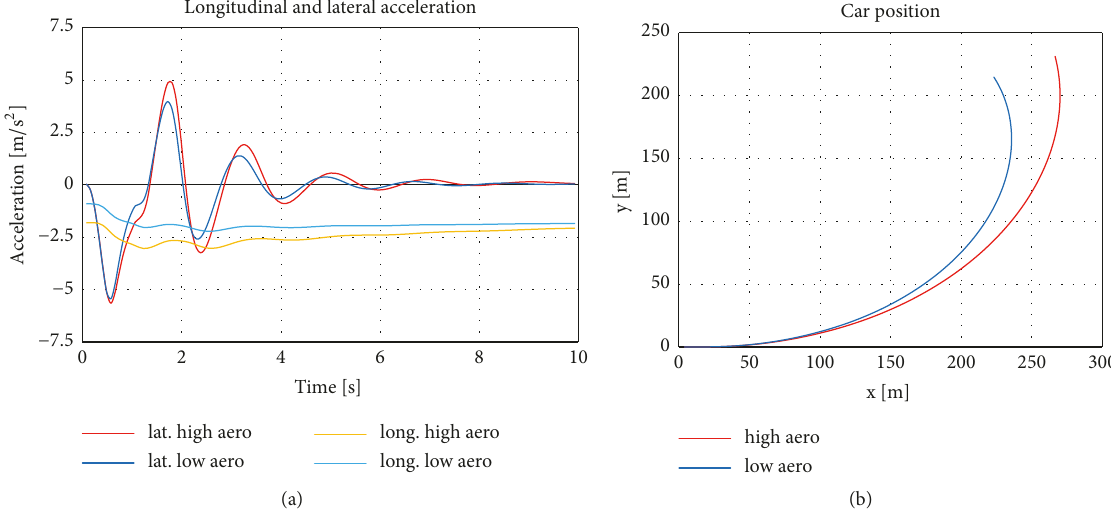
Figure 16: (a) Variation of the longitudinal and lateral acceleration during cornering. (b) Car position influenced by the aerodynamic forces.